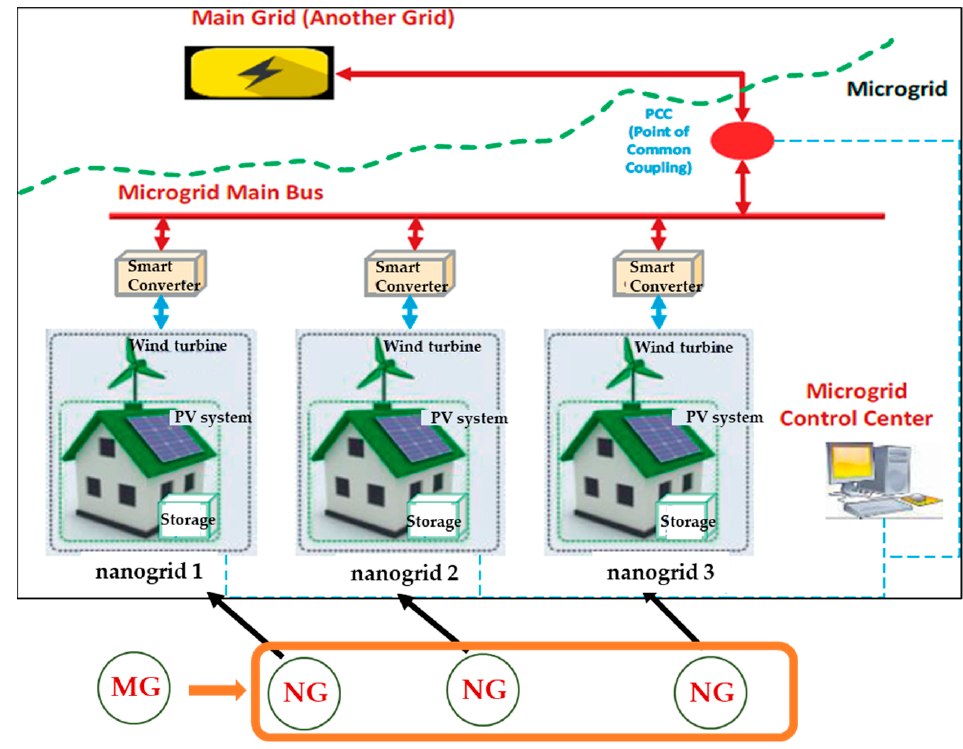
Figure 1. Schematics of nanogrid and microgrid.